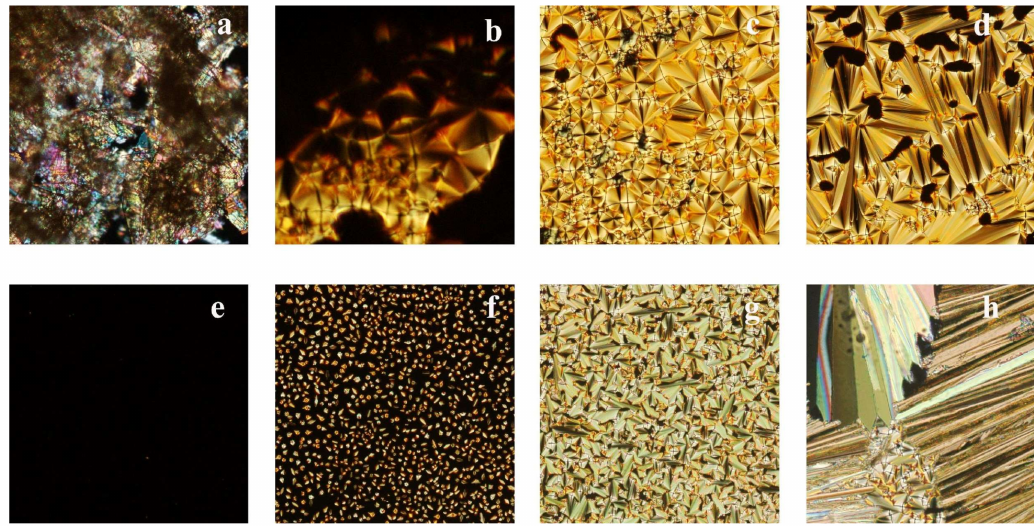
Figure 4. POM textures of compound 2c. ( a ) below 88 ◦ C, crystal; ( b ) at 90 ◦ C, smectic phase; ( c ) at 100 ◦ C, smectic phase; ( d ) at 102 ◦ C, transition smectic-nematic; ( e ) at 115 ◦ C, isotropic phase; ( f ) cooled from isotropic liquid, at 102 ◦ C, nematic phase; ( g ) at 80 ◦ C, transition nematic-smectic; and ( h ) at 64 ◦ C, transition smectic-crystal (100 ×